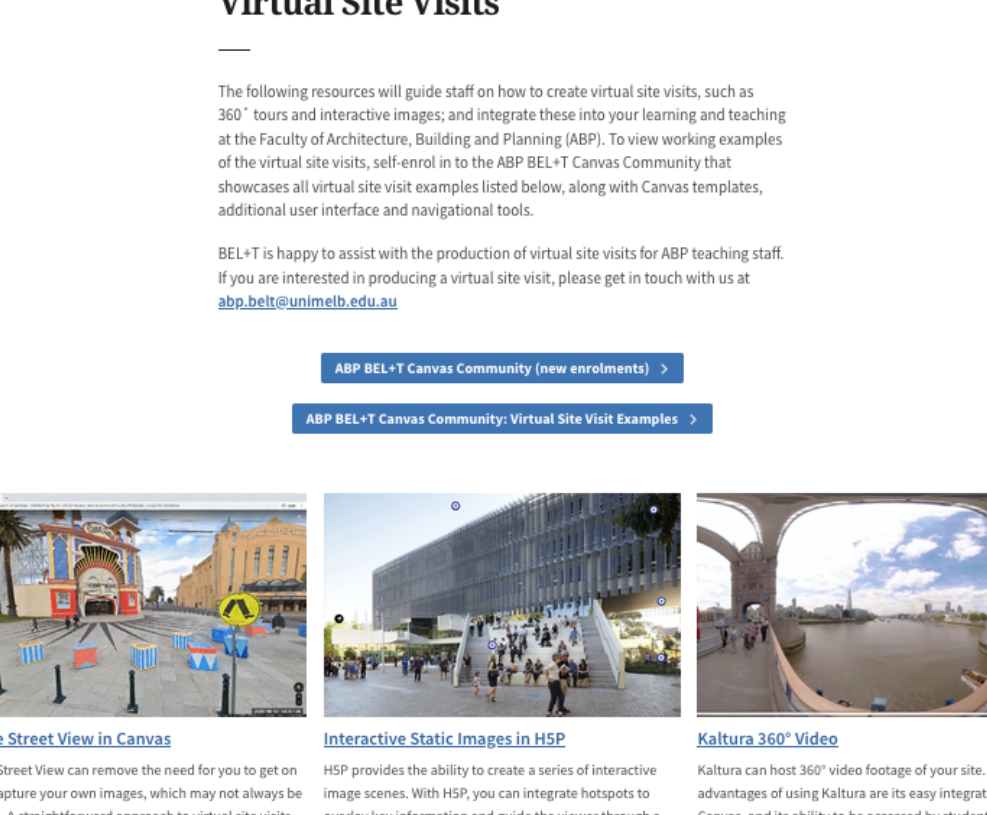
Figure 4. Virtual site visit staff hub with how-to guides (Source: https://msd.unimelb.edu.au/belt/